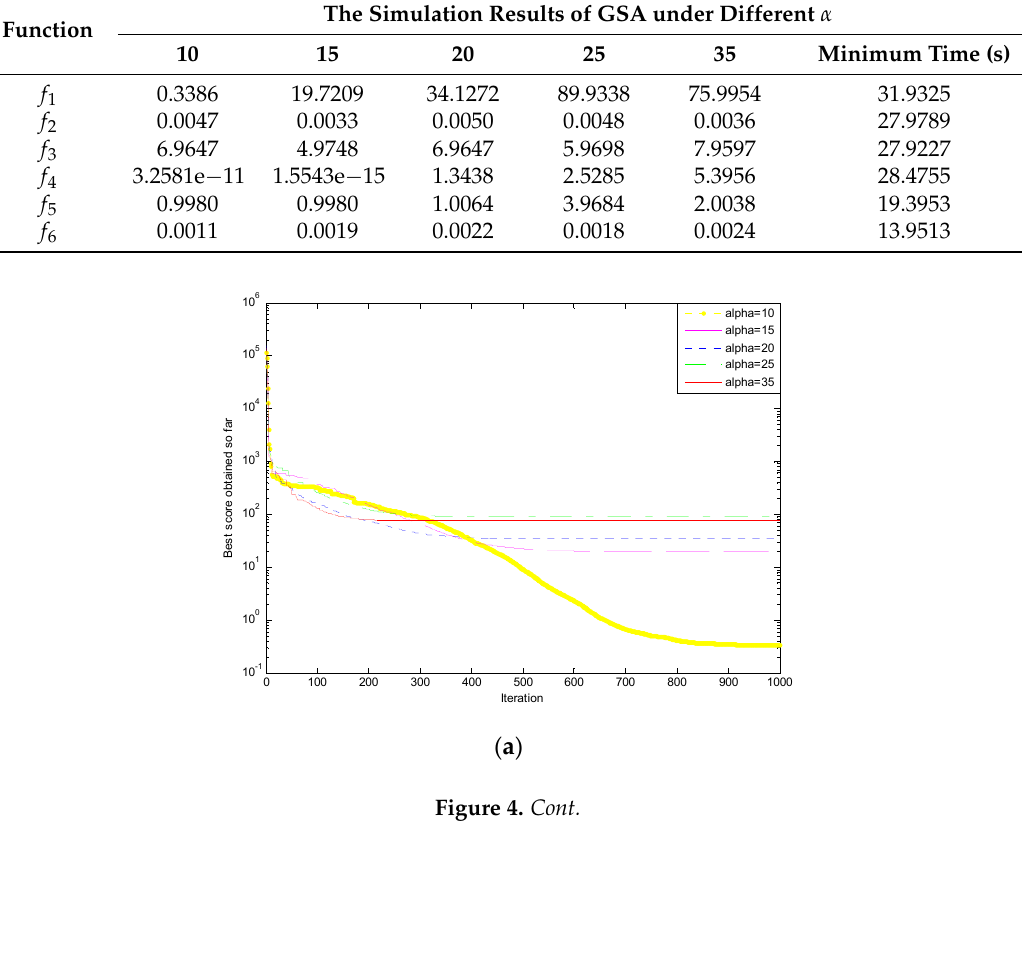
Table 3. The simulation result of different α .